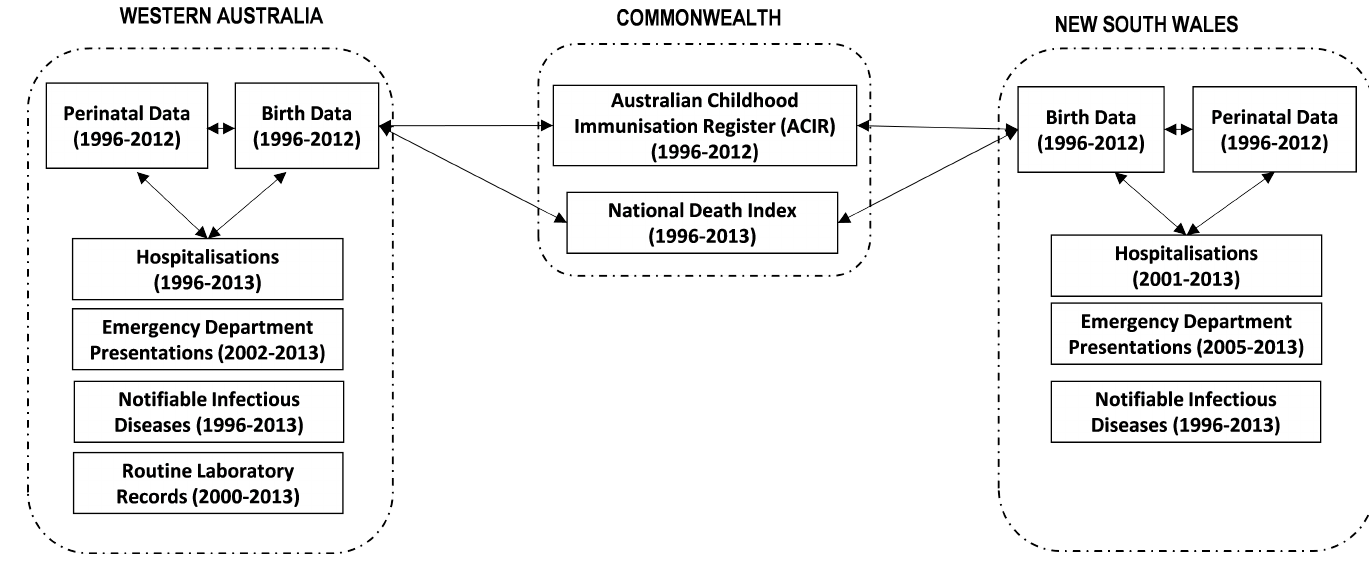
Figure 1: Data sources, years available, and their relationship through